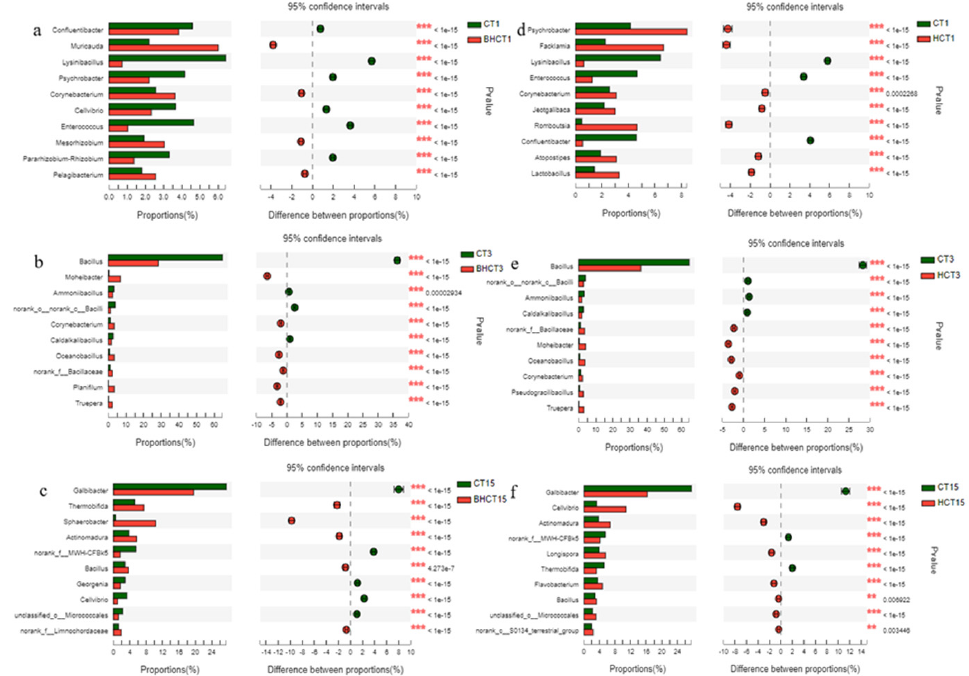
Figure 4. Paired Fisher’s exact test bar plot on the genus level between BHCT, HCT, and CT during three different composting stages: ( a ) CT1-HCT1, ( b ) CT3-HCT3, ( c ) CT15-HCT15, ( d ) CT1-BHCT1, ( e ) CT3-BHCT3 ( f ) CT15-BHCT15.